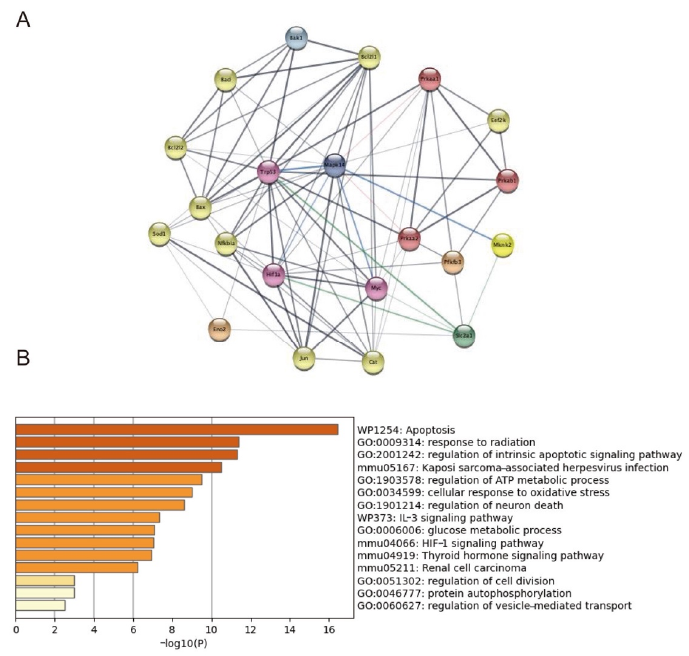
in regulating AMPK α /p38MAPK/GLUT1 signaling cascades. The PPI ( A ) and functional enrichment Figure 7. Potential molecules (Trp53, Mknk2, Myc, HIF1-α, Eno2, and Pfkfb3) targeted on p38MAPK analysis ( B ) of targeted genes generated from the GEO public dataset using in regulating AMPKα/p38MAPK/GLUT1 signaling cascades. The PPI ( A ) and functional enrichment analysis ( B ) of targeted genes generated from the GEO public dataset using IPA.